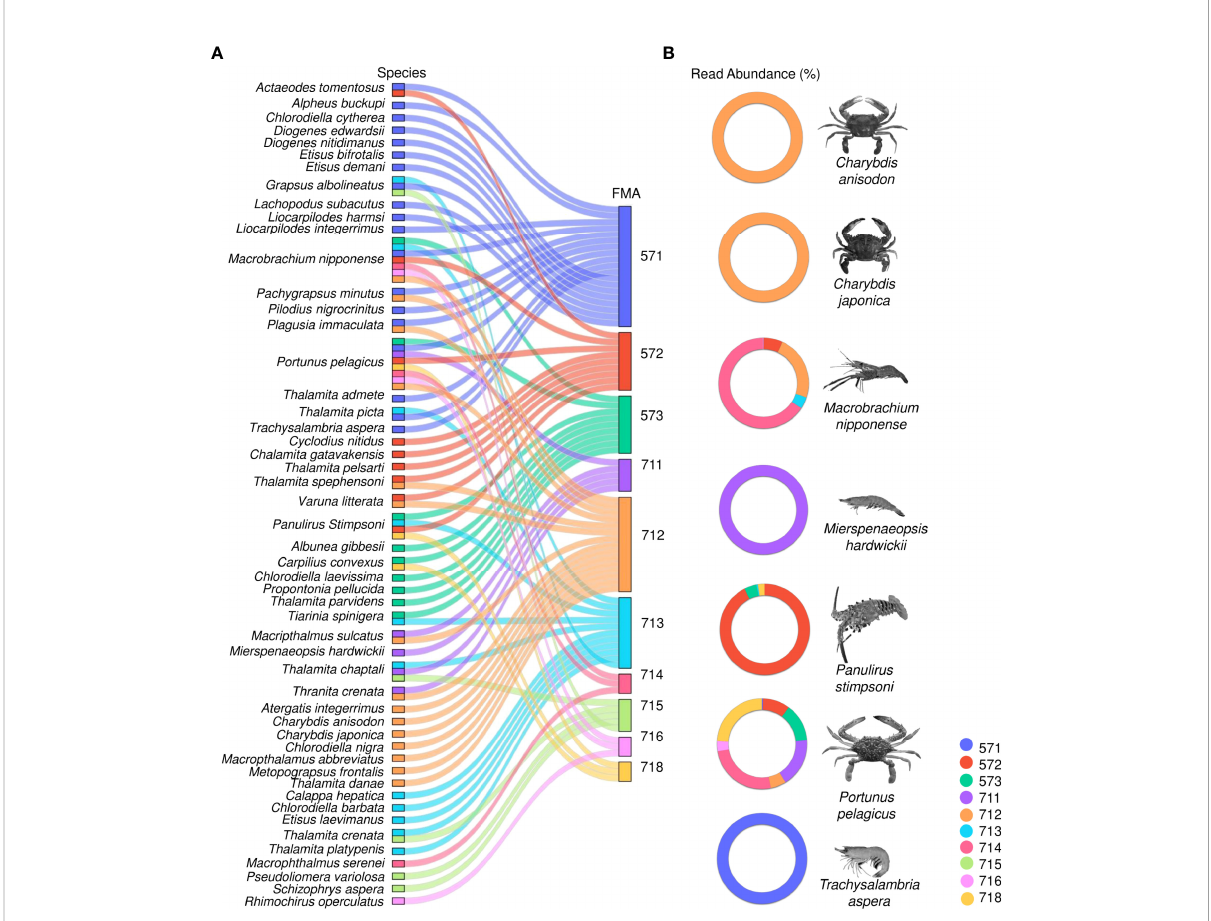
FIGURE 8 Parcat graphs showing: (A) the taxonomic distribution by Fisheries Management Area (FMA) of all decapod species identi fi ed from eDNA; and (B) the relative abundance (read percentage) by Fisheries Management Area (FMA) of the seven economic ( fi sheries target) decapod species identi fi